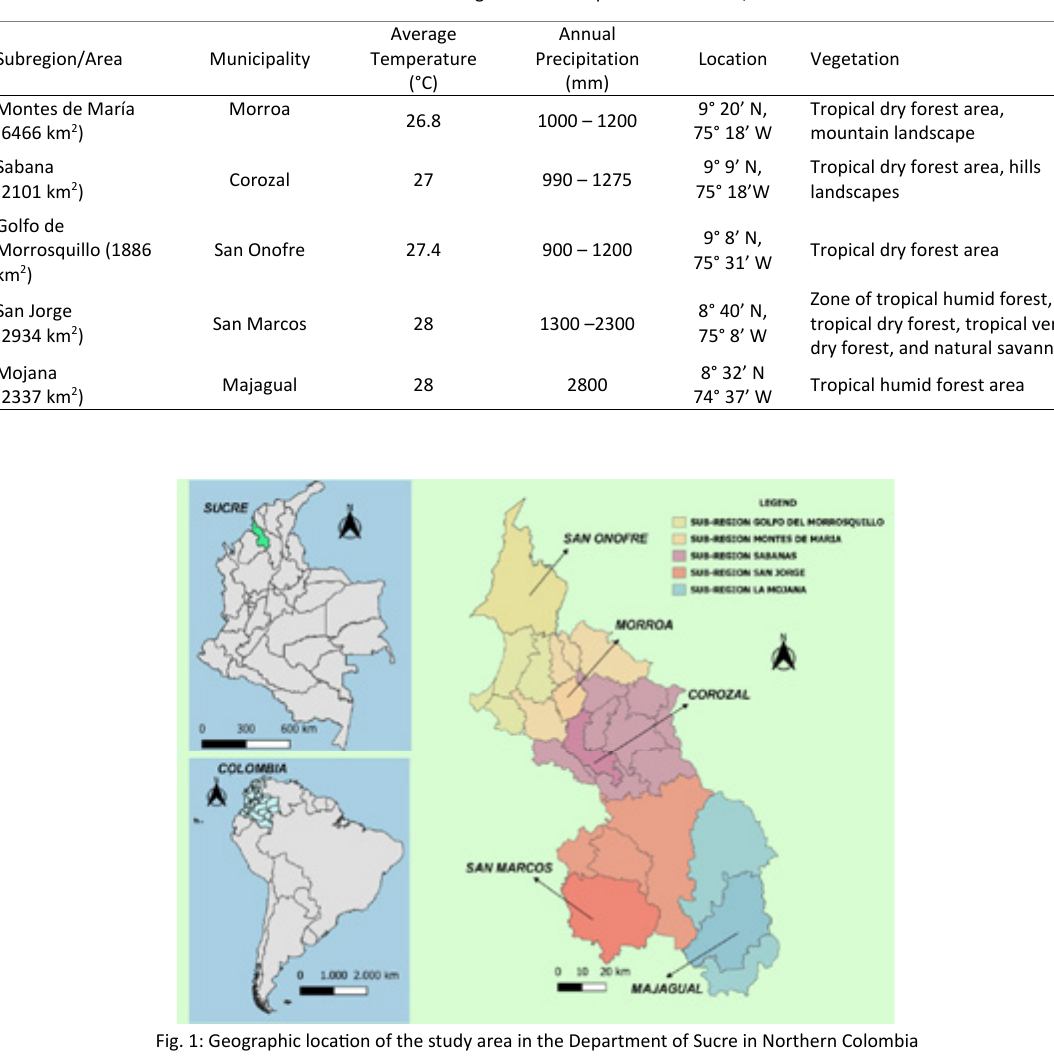
Table 1. Characteristics of the five sub-regions of the department of Sucre, in northern Colombia.